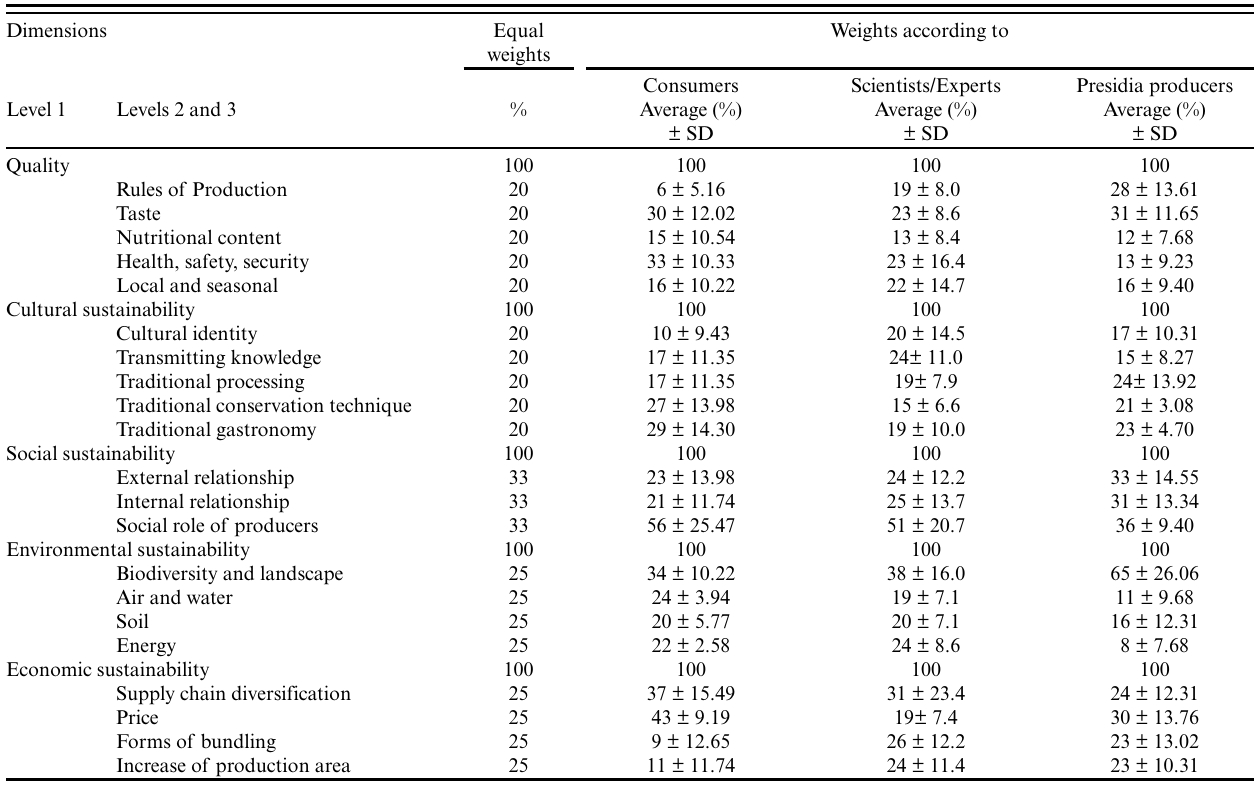
Table 4 . Weights (average and standard deviation) assigned to each of the indicators by different stakeholders within the five dimensions of quality, economic sustainability (both at level 3), and cultural, social, and environmental sustainability (at level 2). Dimensions